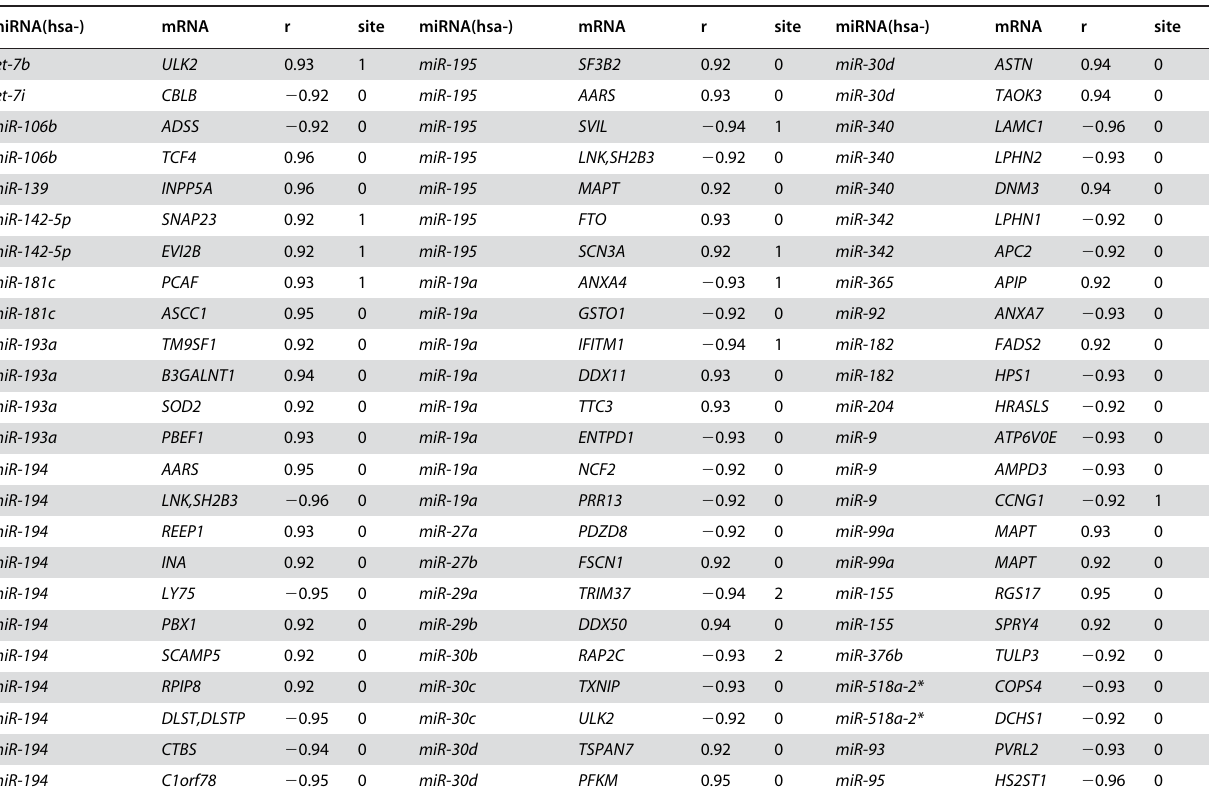
Table 1. List of miRNA-mRNA high correlation pairs and number of predicted target sites. .. ... .... ... ... .... ... ... .... ... ... .... ... ... .... ... ... .... ... ... .... ... ... .... ... ... .... ... ... .... ... ... .... ... ... .... ... ... .... ... ... .... ... ...